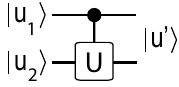
Figure 9: Controlled-U